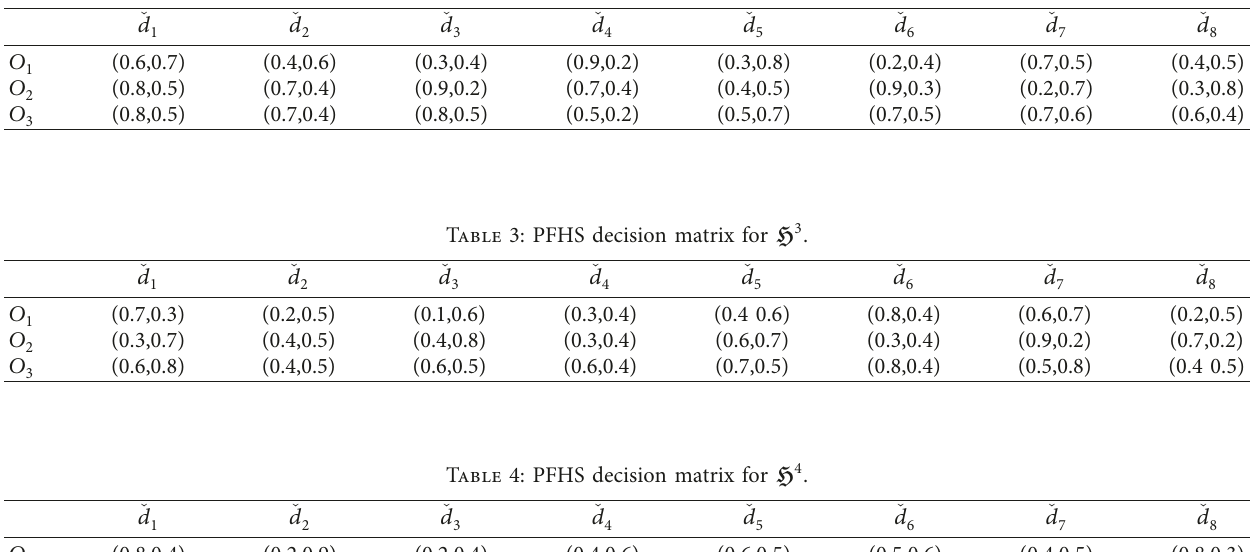
Table 2: PFHS decision matrix for H 2 .